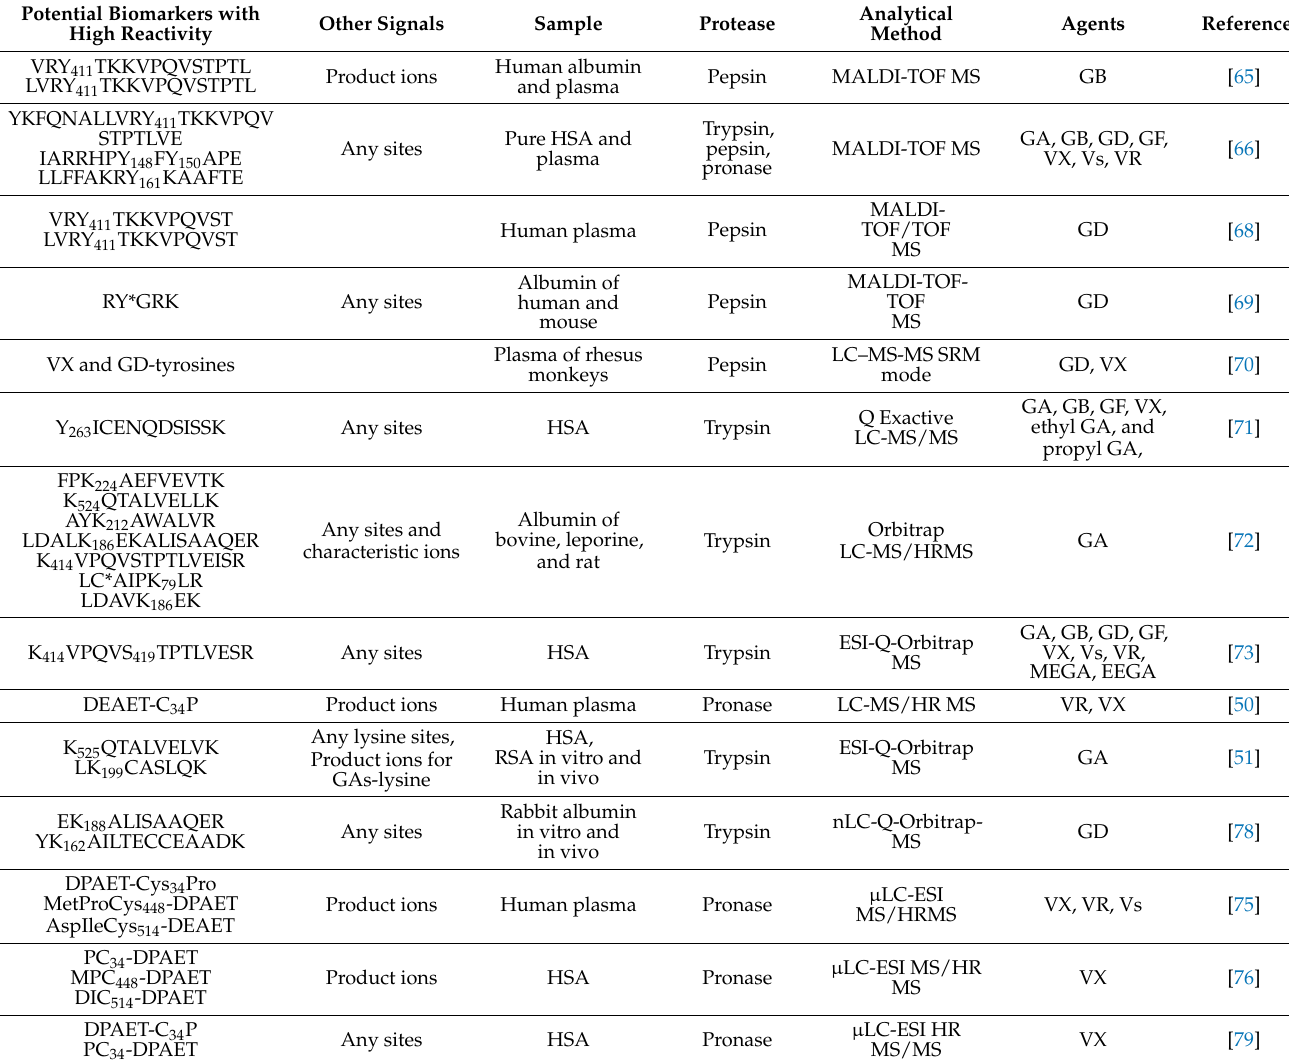
Table 1. Potential biomarkers with high reactivity and related signals of albumin